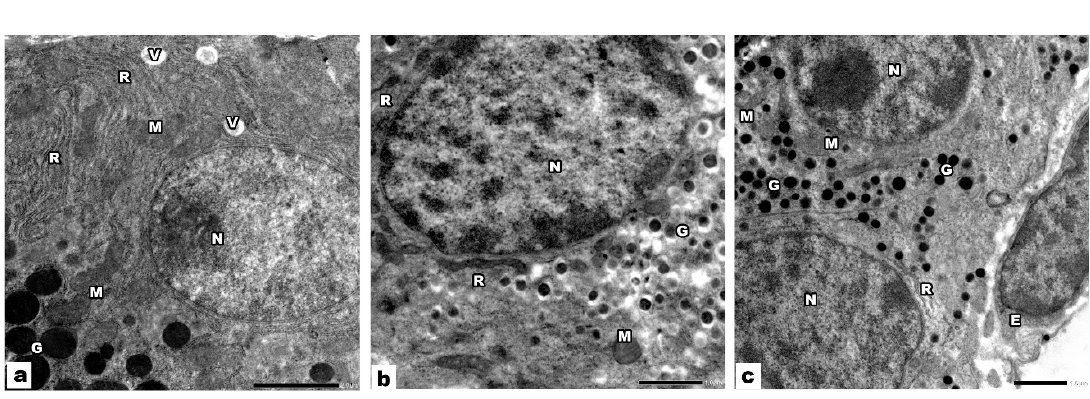
Figure 5. Electron micrographs of VPA and ALA treated pancreatic sections. ( a ) The acinar cells have rounded euchromatic nuclei (N), the cytoplasm shows parallel cisternae of rER (R), mitochondria (M), electron-dense granules (G), and small vacuoles (V). ( b ) β cells of the islets of Langerhans have euchromatic nuclei (N), electron-dense granules encircled by halo (G), mitochondria (M), and rER (R). ( c ) α cells have euchromatic nuclei (N), many electron-dense granules (G), rER (R), and mitochondria (M). Note the endothelial cell (E) of the blood capillary.